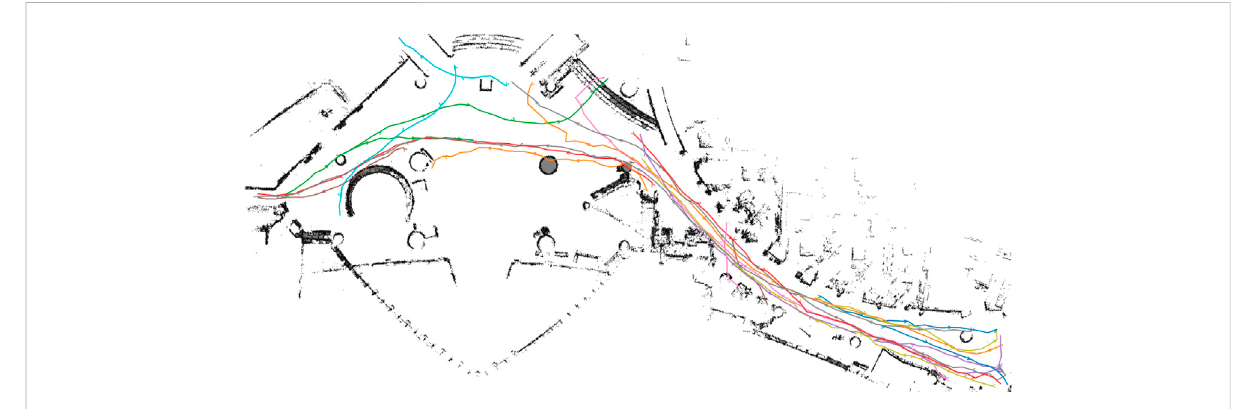
FIGURE 10 Pedestrian paths from time-point t1 used for execution phase experiments in the ATC